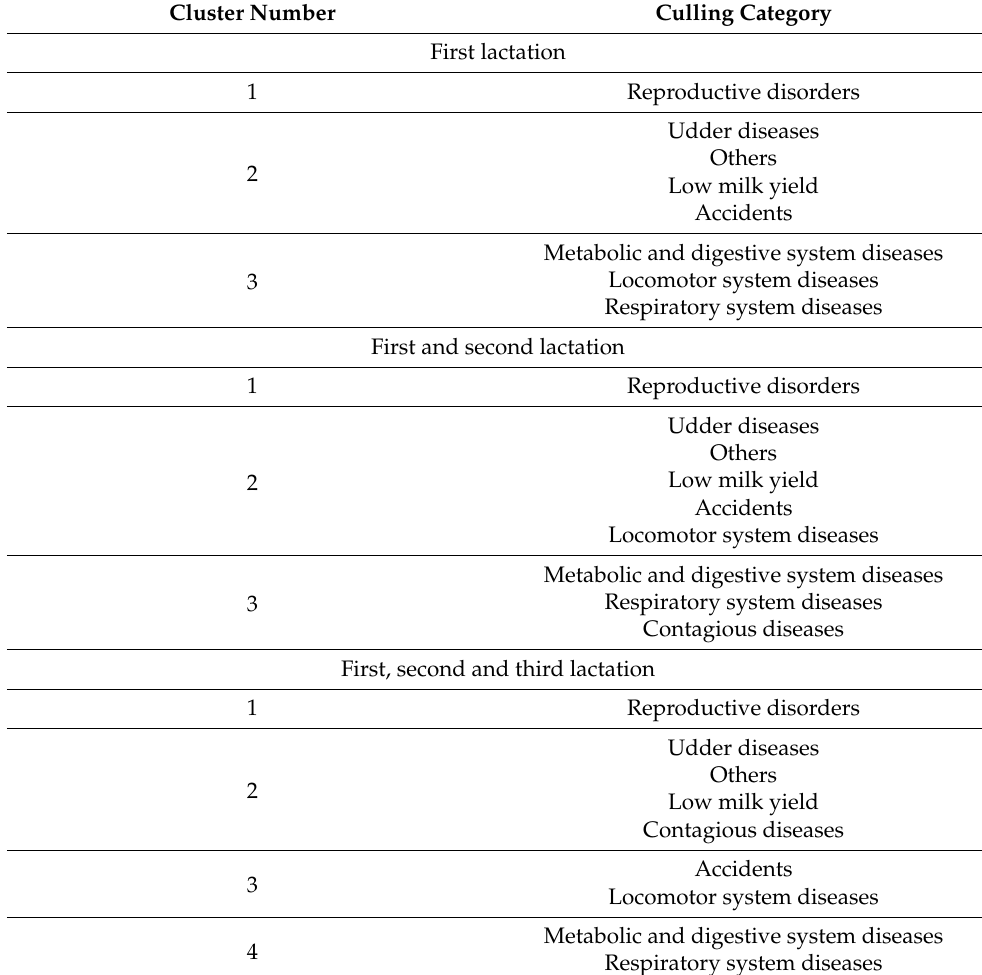
Table 5. Cluster elements for the k -means clustering